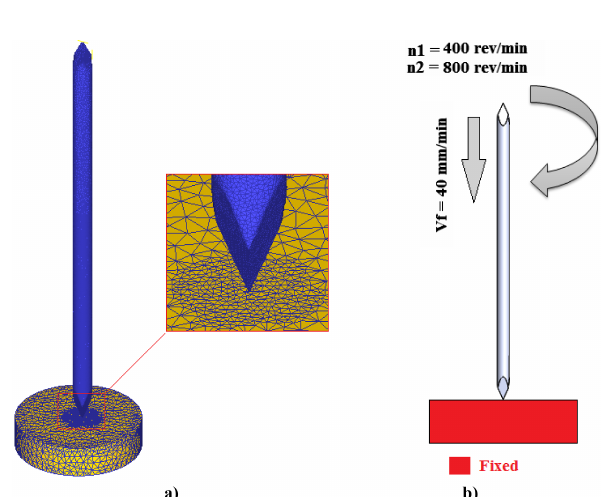
Figure 4. Schematic circuit view of bone model drilling test unit.